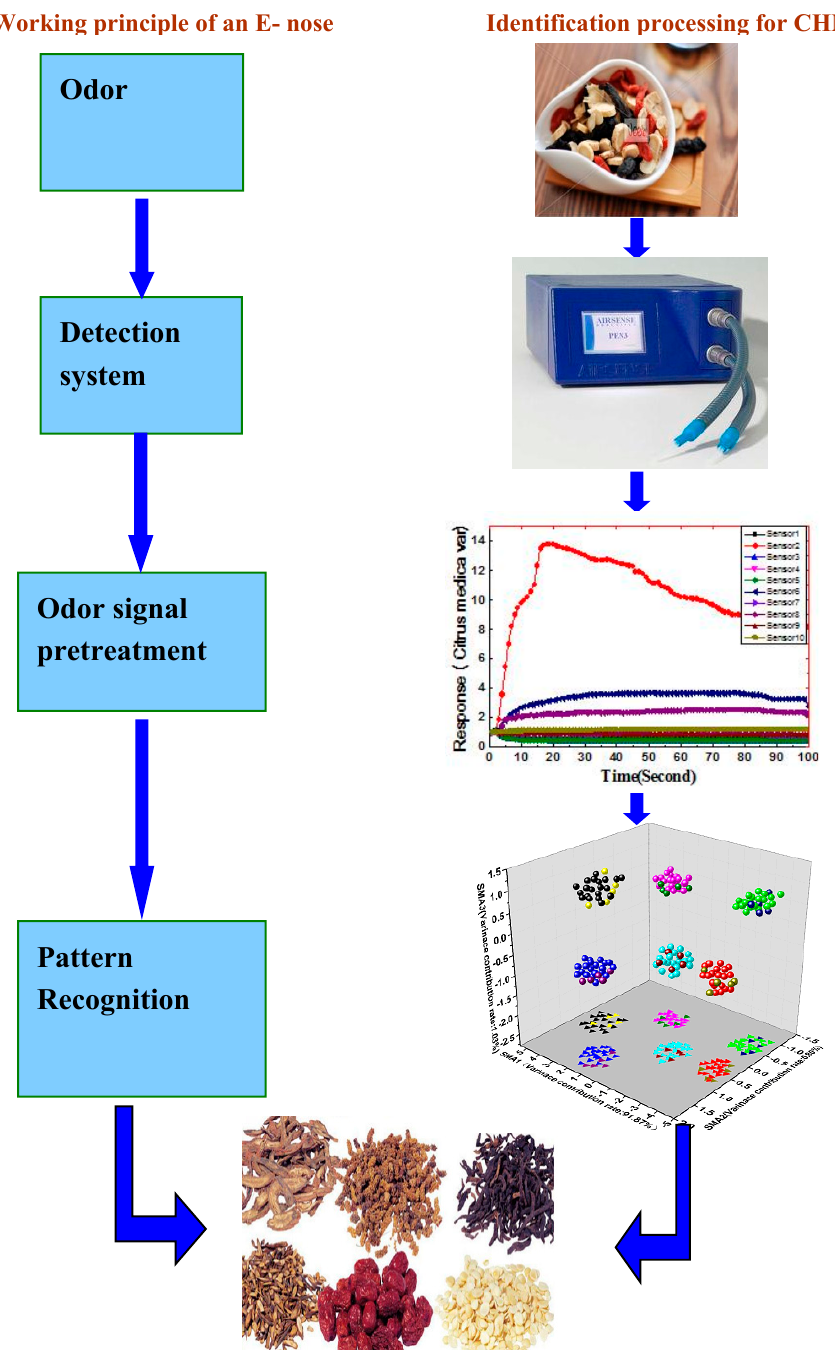
Figure 2. The working principle of an E-nose and the identification processing for CHMs.